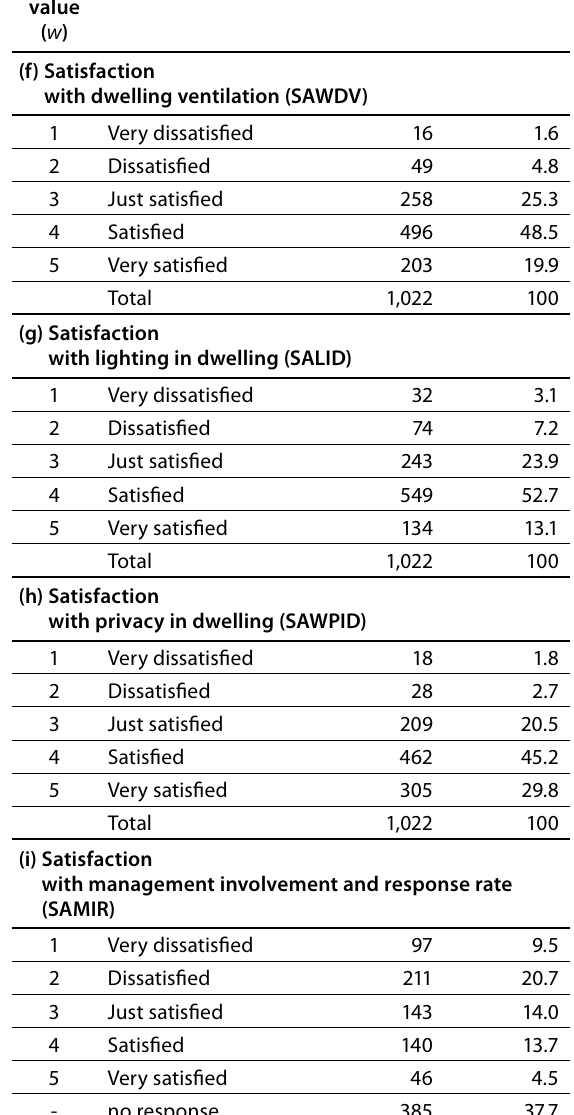
Table 3. respondents’ (tenants’) satisfaction level with housing Weight